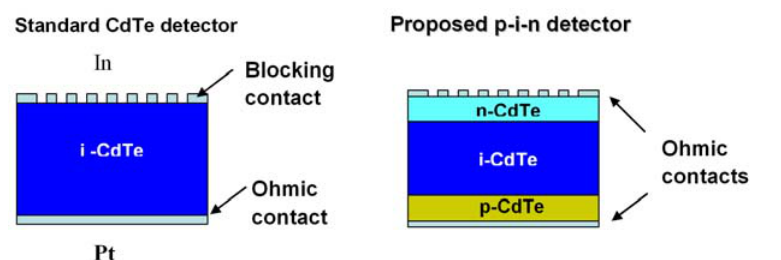
Figure 7. Standard and proposed detector structures.